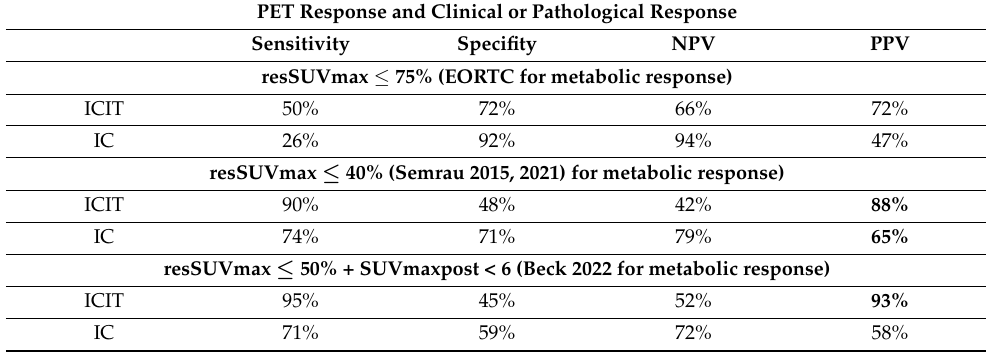
Table 3. PET response with different thresholds testing for CR.